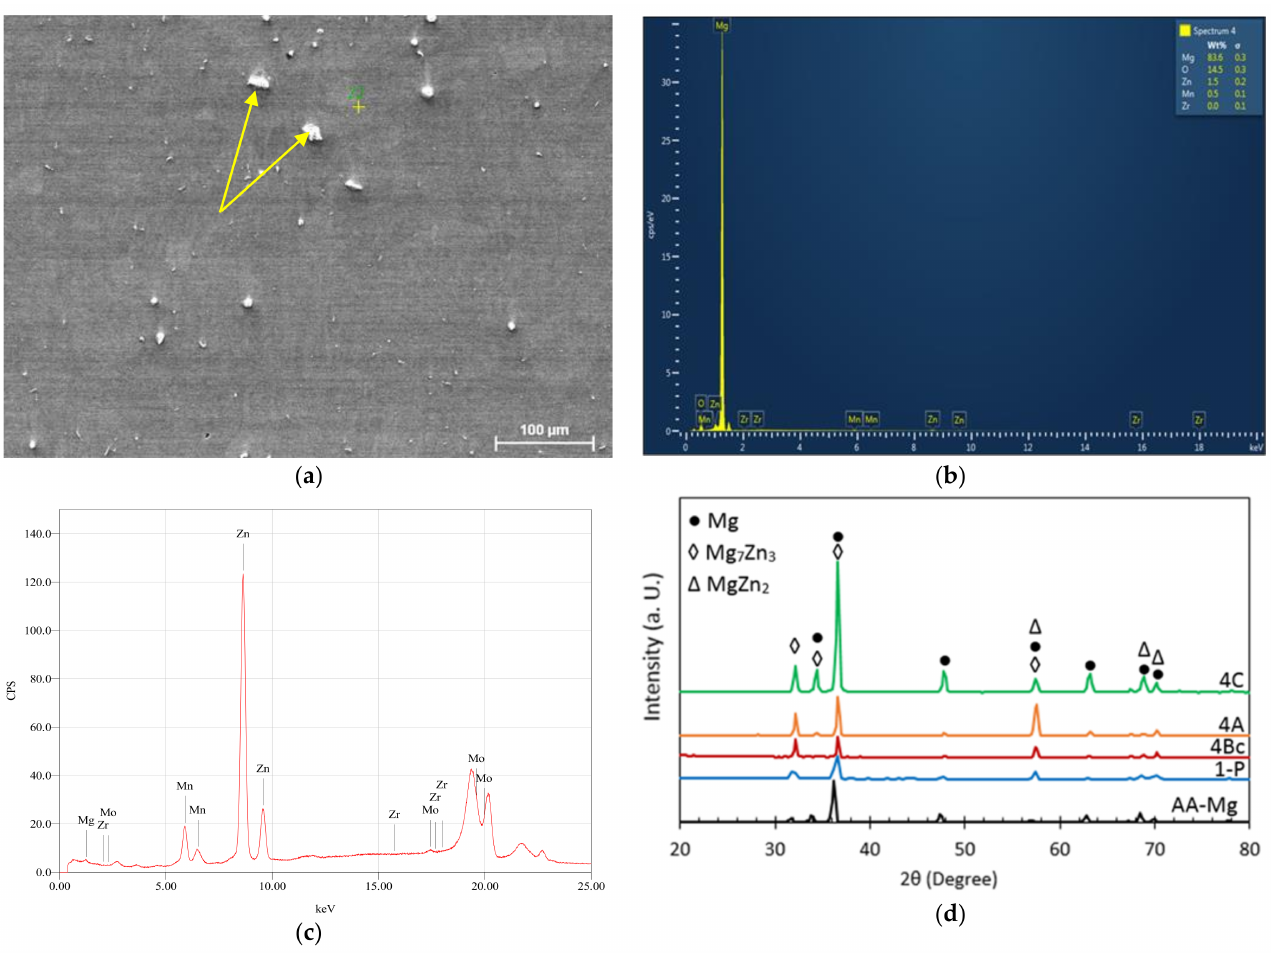
Figure 2. ( a ) SEM micrographs, ( b ) EDS analysis, ( c ) XRF analysis of the AA ZK30 billets, and ( d ) XRD pattern diffractions of the ZK30 alloy before and after ECAP processing; arrows point at second